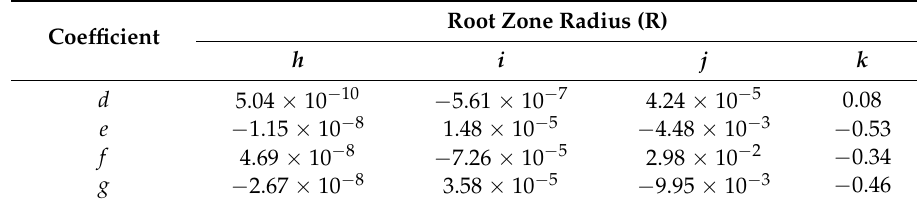
Table 2. The parameters of the root zone radius model.